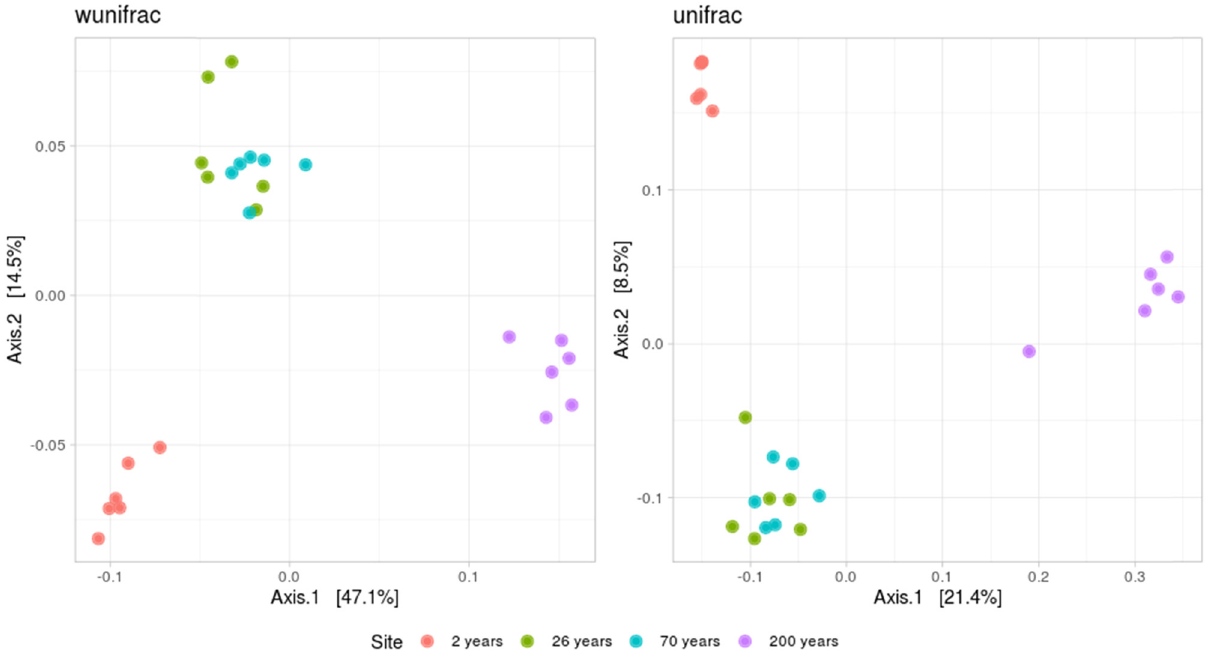
Figure 5: Weighted ( 1 ) and unweighted ( 2 ) Unifrac ordinations of the soil prokaryotic